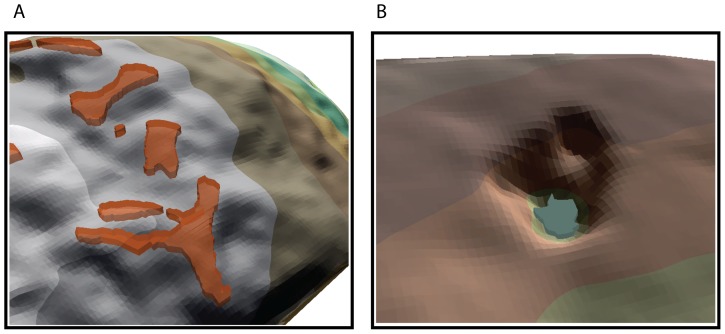
Three-dimensional representations of two polygons identified by the hotspot analysis.The polygons have been draped over the three-dimensional surface of these specimens. A) Represents a hot spot identified on an experimental hammerstone B) Represents a hot spot on a naturally damaged cobble.